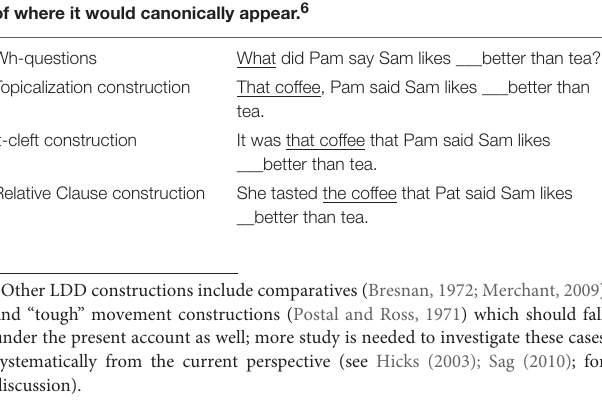
TABLE 2 | Examples of long distance dependency (LDD) constructions: constructions in which a constituent appears in a fronted position instead of where it would canonically appear.